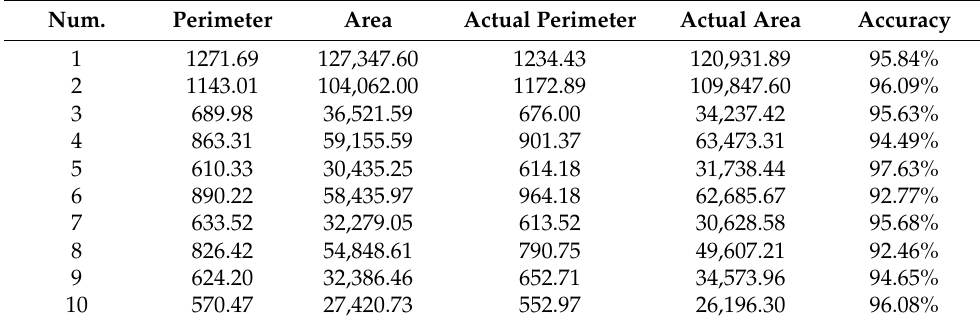
Table 1. Algorithm’s